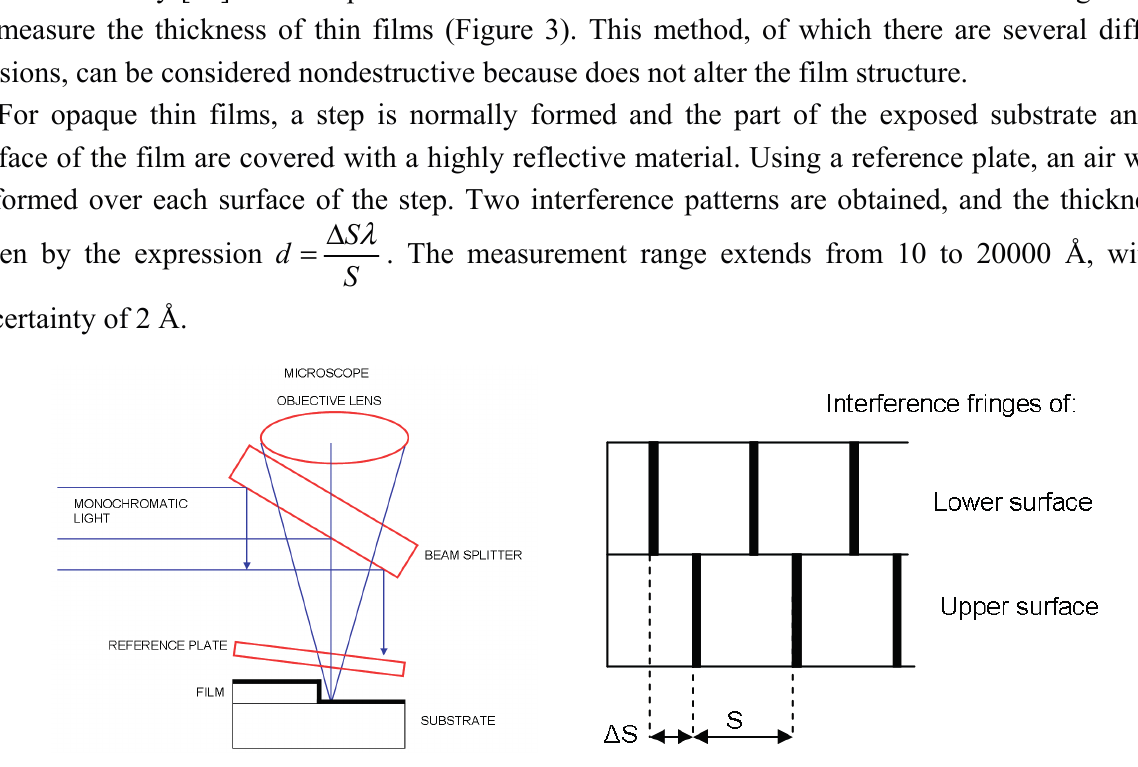
Figure 3. Diagram of monochromatic light interference-based thickness measurement process for opaque